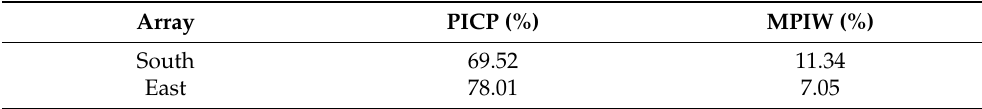
Table 2. Metrics for evaluating interval